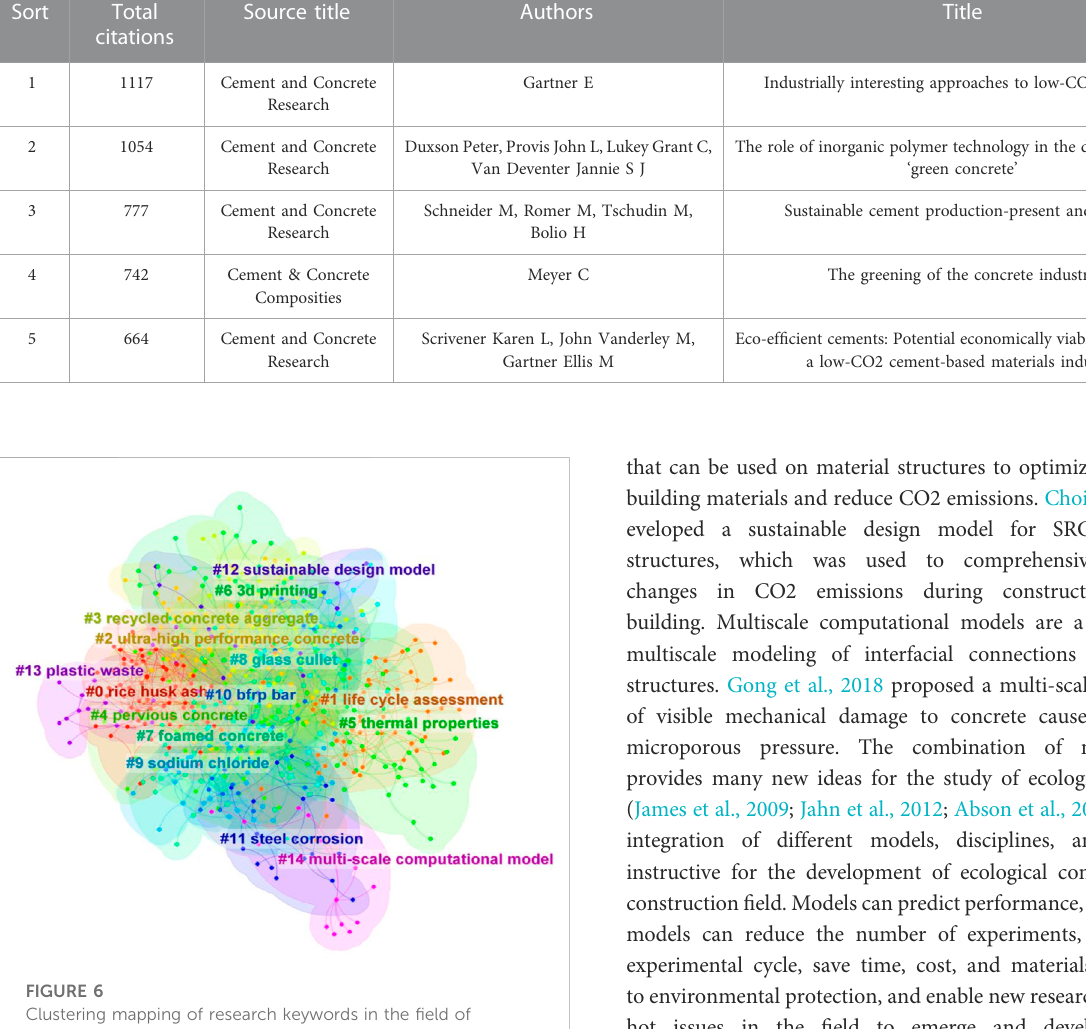
TABLE 7 Top fi ve highly cited literature for research in the fi eld of ecological concrete construction. Sort